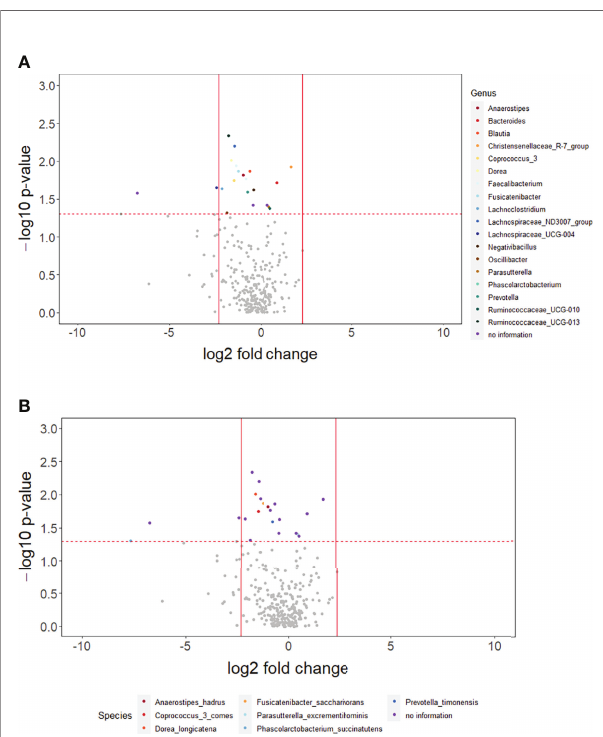
FIGURE 1 | The overall difference of gut microbiota between the constipated group and the non-constipated group was assessed. A negligible number 2*10 -6 was added to the abundance of every amplicon sequence variant (ASV) to avoid the value of the magnitude of fold change being in fi nitely large or small. This number was generated based on the 100th of the minimal relative abundance. Each point represents an ASV with its magnitude fold change in relative abundance (log2 of the constipated group/non-constipated group) on the x - axis and the value of statistical signi fi cance ( − log10 of p -value) on the y -axis. The dashed red line shows where p = 0.05 with points above the line having p < 0.05 and points below the line having p > 0.05. Signi fi cant ASVs are colored based on genus (A) and species (B) . Points outside of the solid lines are ASVs with a mean abundance of 0 in either the non-constipation group (left) or the constipation (right)